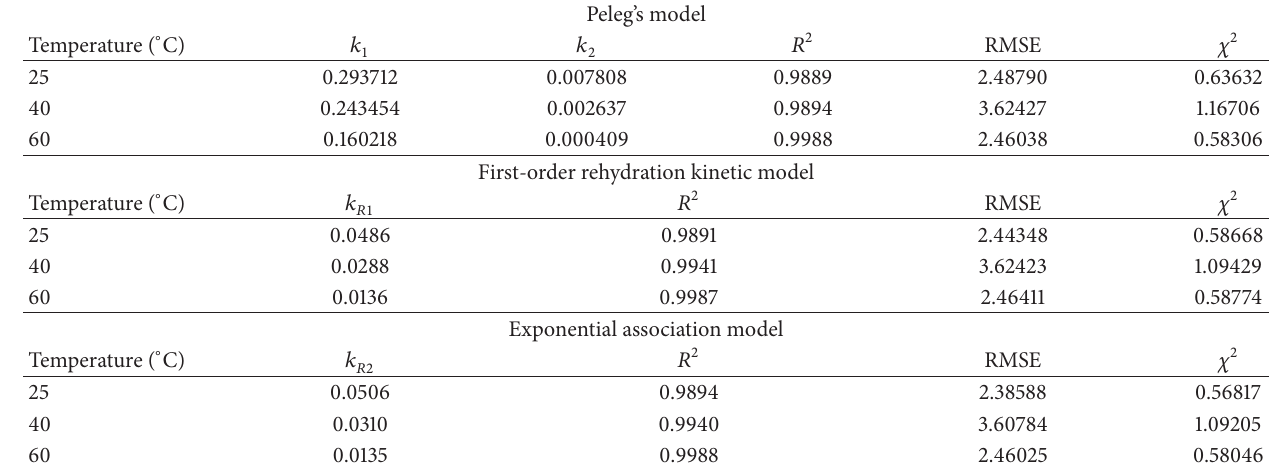
Table 2: Estimated parameters of the models used for various swelling